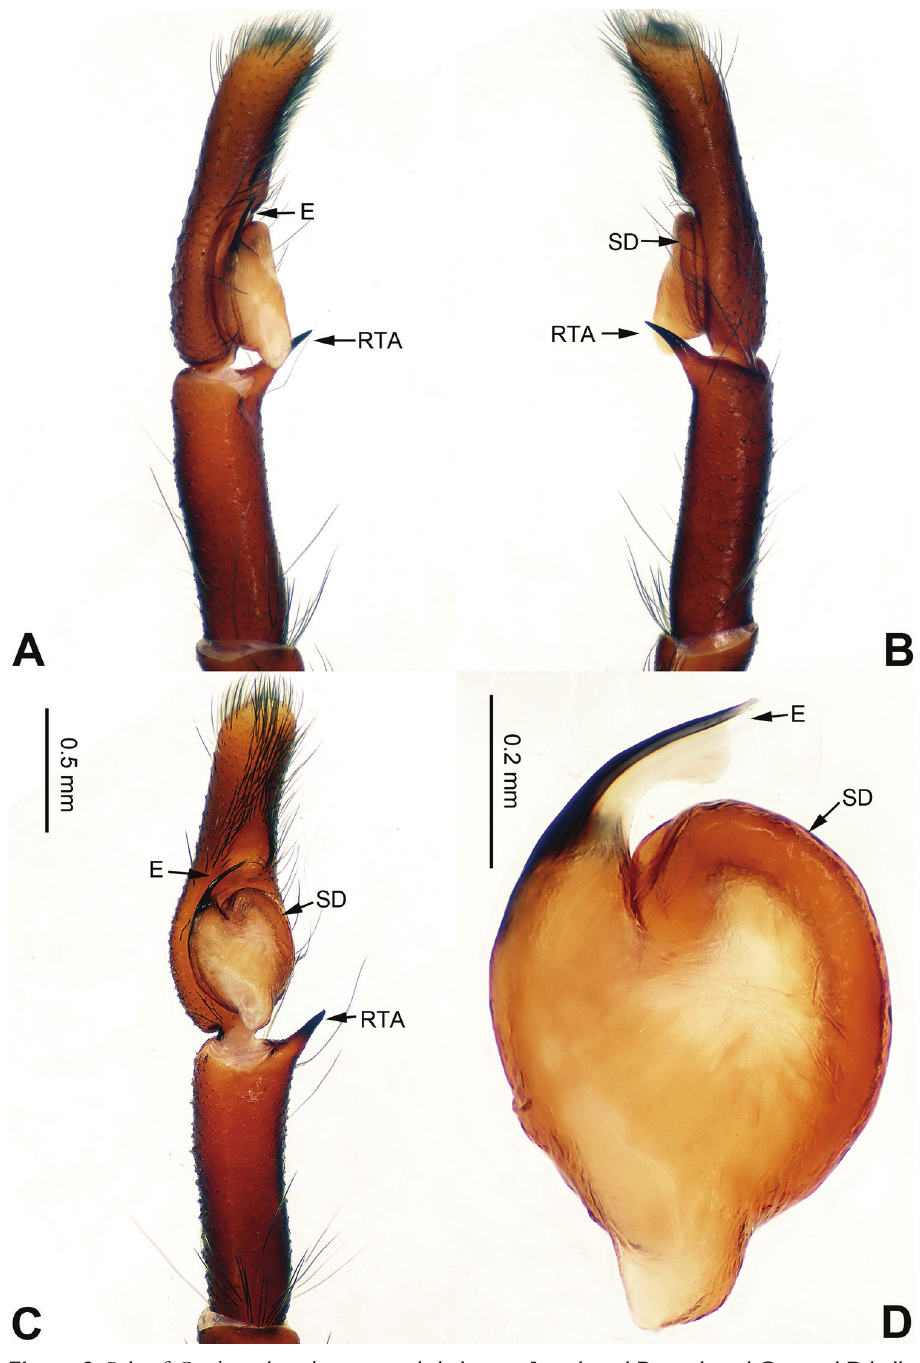
Figure 9. Palp of Carrhotus kevinlii sp. n., male holotype. A prolateral B retrolateral C ventral D bulb, ventral. Scale bar equal for A–C